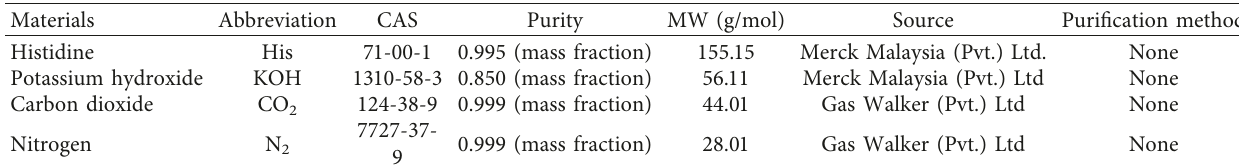
Table 2: List of materials